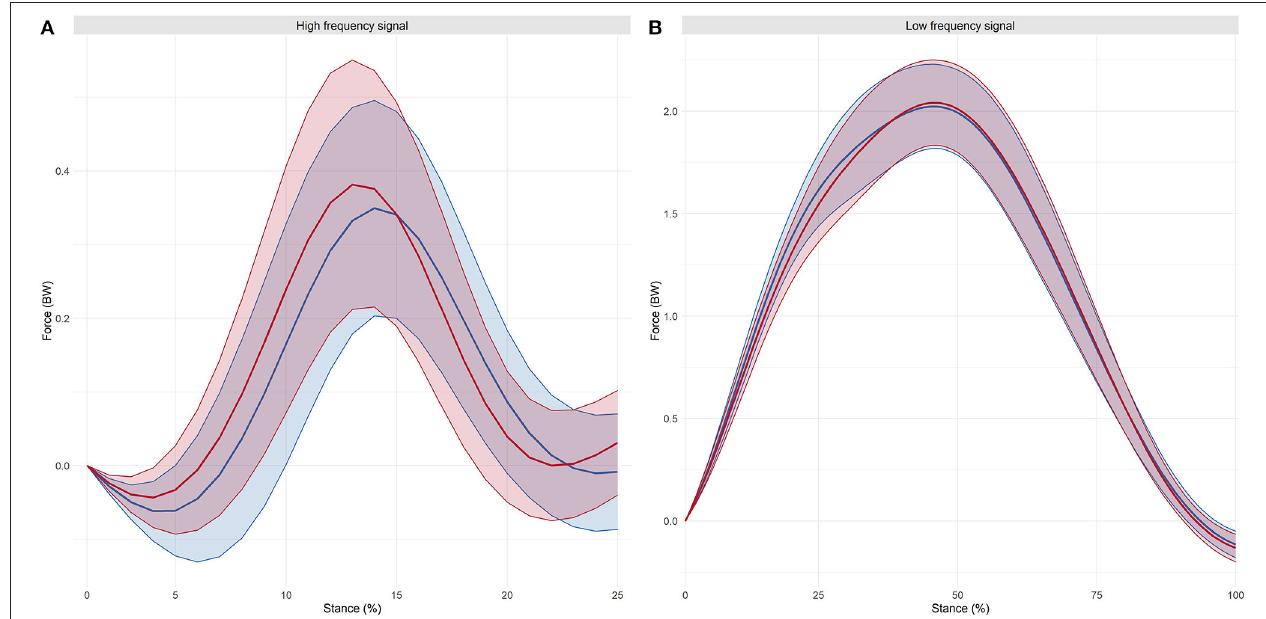
FIGURE 5 | Ensemble-averaged curves of the high (A) and low (B) frequency signals in the two experimental groups (Red: Hard shoe group; Blue: Soft shoe group). Thick line is the shoe group’s ensemble-average mean, and thin lines are 1 SD below and above the mean.